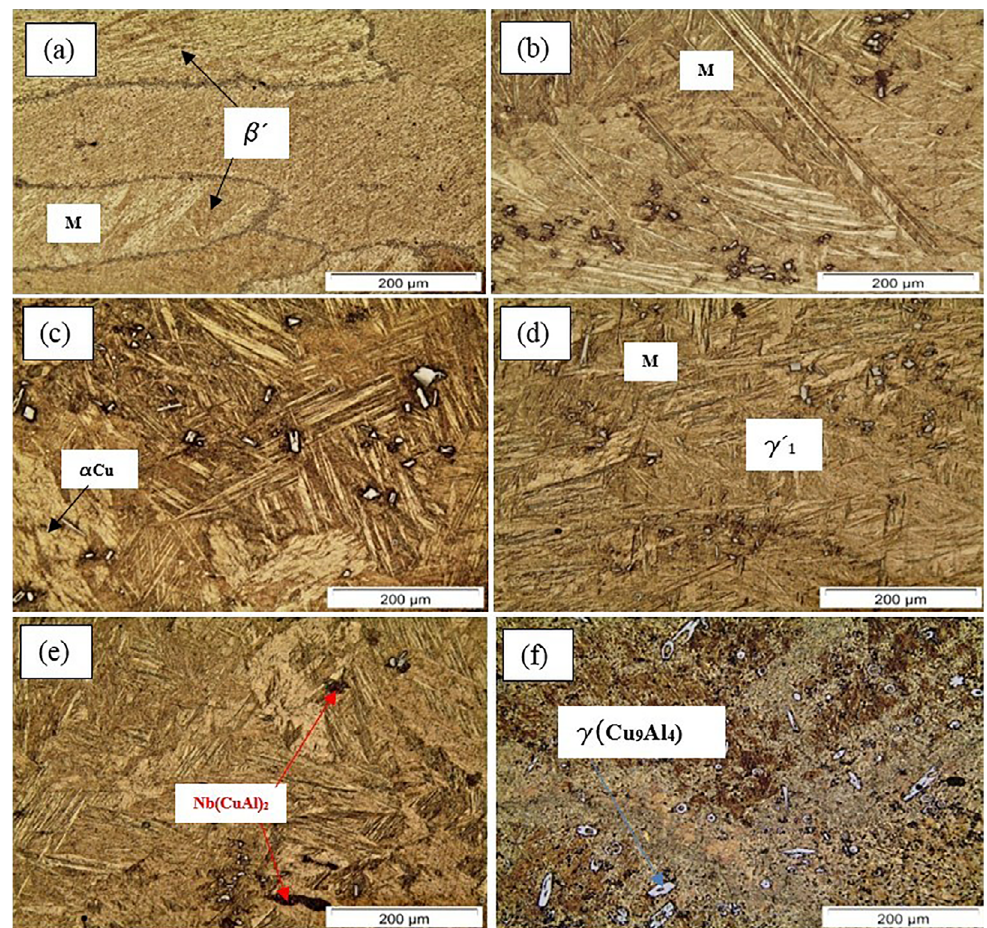
Figure 4. OM images revealing fine and coarse martensite as well as precipitate particles in the microstructure of the Cu-Al-Nb alloys. (a) 0.5 %Nb; (b) 1.0 %Nb; (c) 1.5 %Nb; (d) 2.0 %Nb; (e) 2.5 %Nb; (f) 3.0